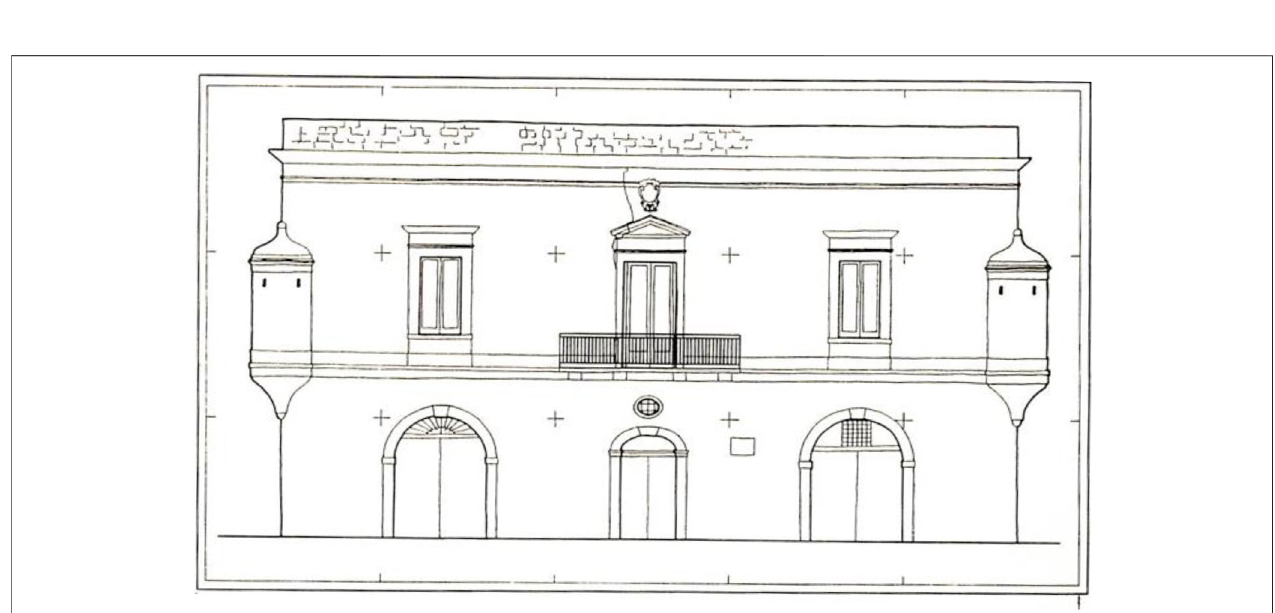
FIGURE4| FaçadeofMasseria “ Jesce ” locatedinsouthernItaly(Basilicataregion),surveyedthroughterrestrialphotogrammetrictechniques(Maneraetal.,1990).